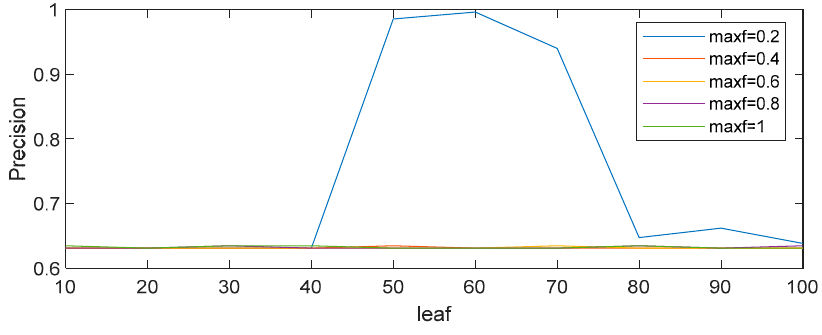
Figure 5. Simulation of leaf and maxf .